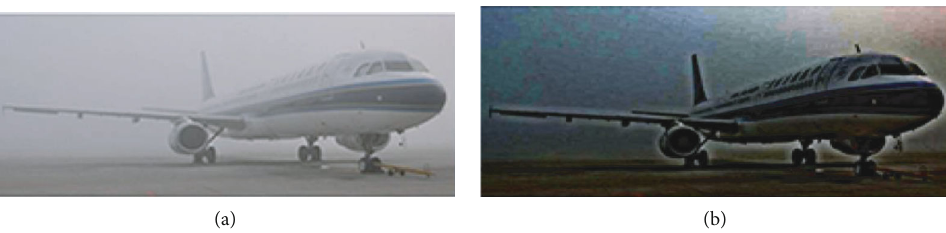
Figure 7: Comparison of the 3rd image target recognition e ff ect. (Note: on (a) is the image unprocessed recognition e ff ect map; on (b) is the recognition e ff ect map processed using the dark channel